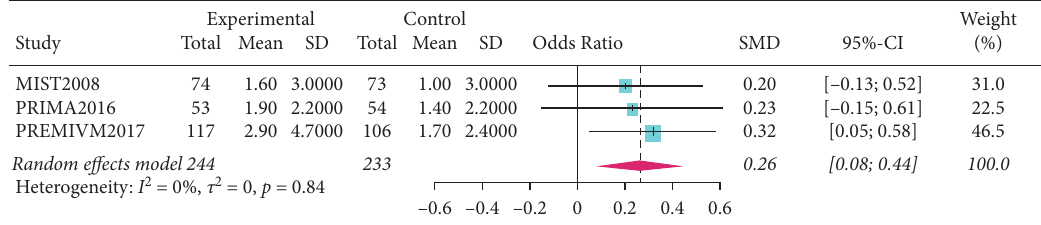
Figure 4: Forest plot for reduction in monthly migraine attacks and monthly migraine days.